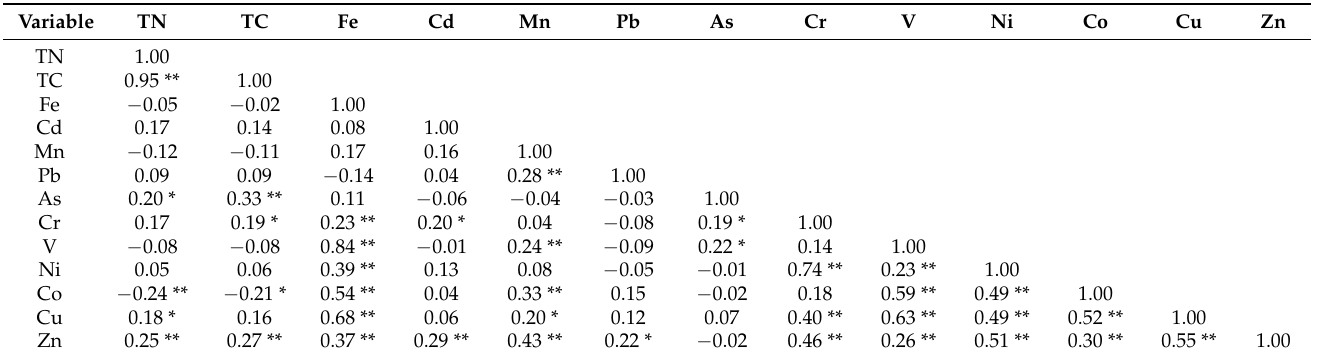
Table 2. Pearson correlation between soil heavy metal(loid)s.